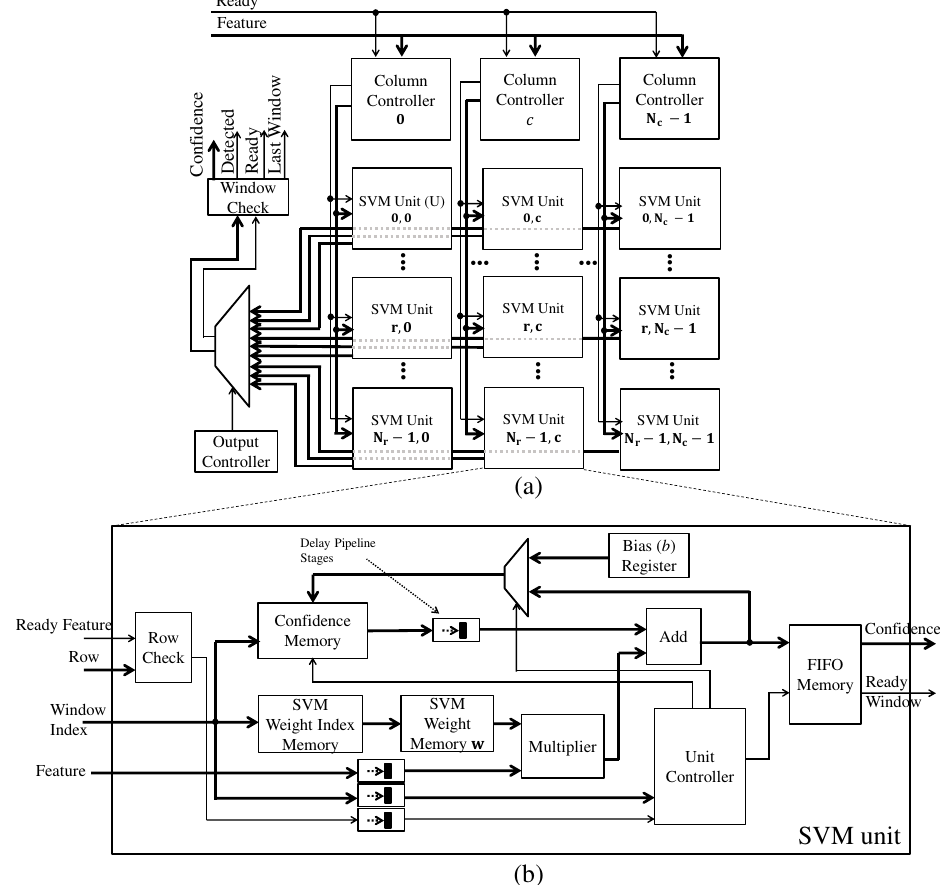
Figure 10. The SVM architecture: ( a ) Units matrix and management ( b ) SVM unit. The detection window processing through the SVM unit starts by accessing the SVM weight index from the detection window index. The SVM weight value, obtained from the weight index, is multiplied by the input feature. This value is added to the temporary confidence value stored in an indexable memory and stored back in this memory.